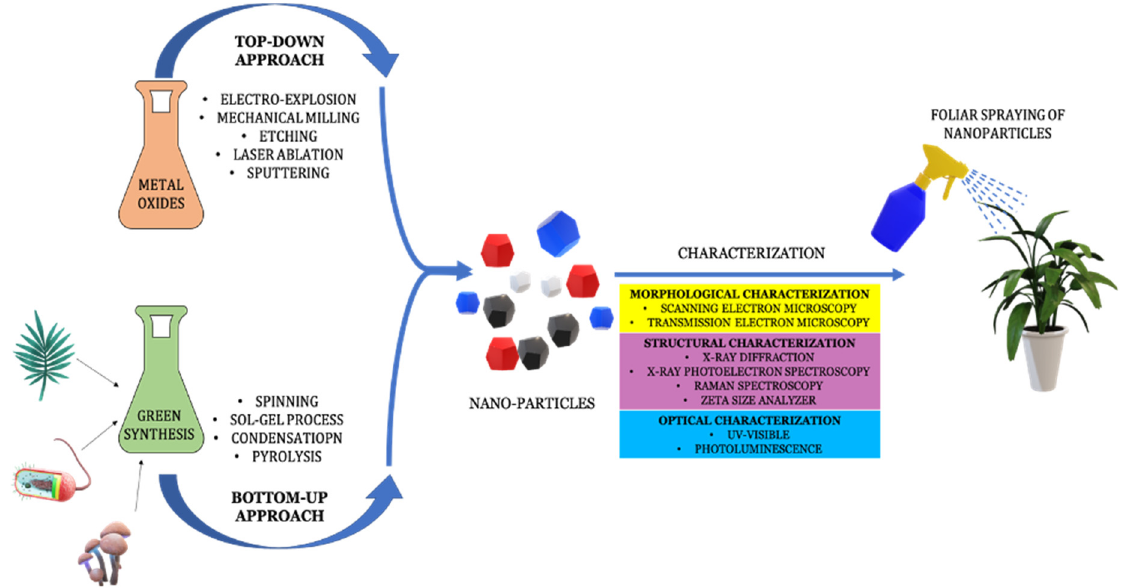
Figure 2. Different approaches for synthesis of nanoparticles and their characterization.